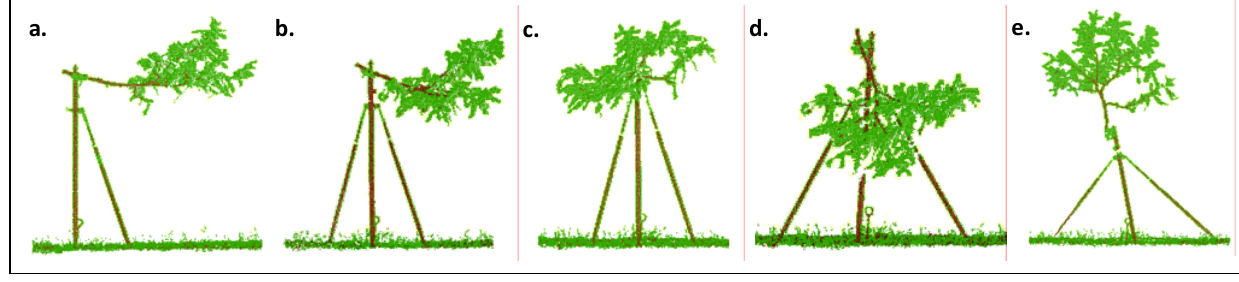
Figure 2. Sample branch scan angles include 0°, 45°, 90°, 45° up, and 45° down. The (a) 0°, (b) 45°, and (c) 90° positions all maintain the branch in the neutral horizontal position as it would be on the bole of the tree, with the branch angle rotated around the vertical ( z ) axis. In contrast, the (d) 45° and (e) 90° positions depict the underside and top views of the branch (rotated around the horizontal, or x -axis) as the branch faces the scanner head on, simulating the effects of a scan from above or below the crown.